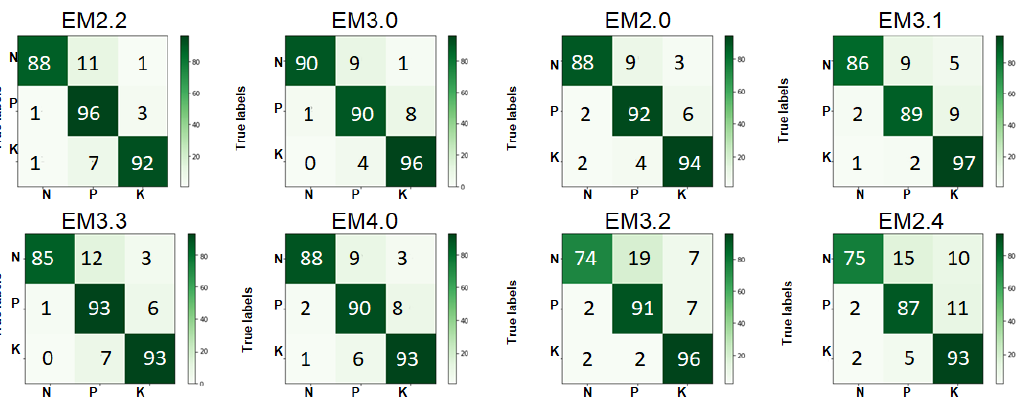
Figure 9. Confusion matrices of the first eight best ensemble classifiers for the Kaggle rice NPK deficiency dataset.